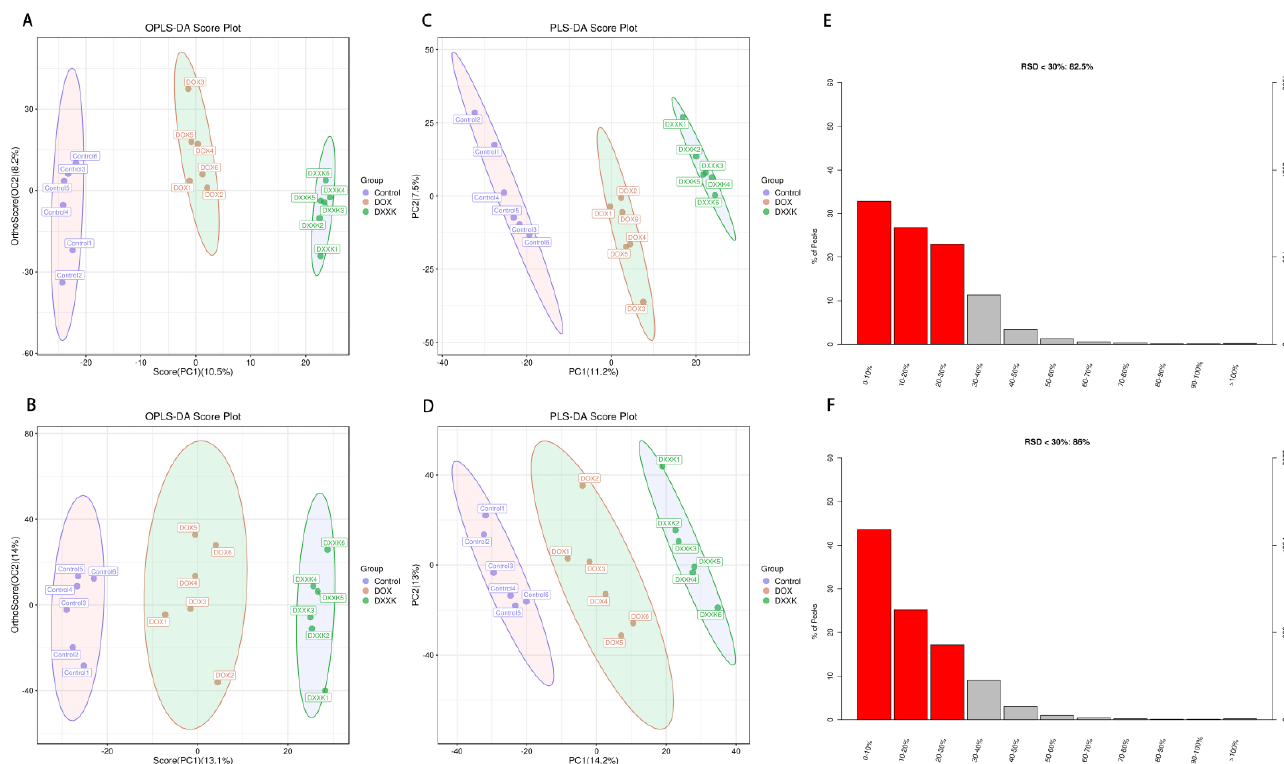
Figure 5. Metabolic profiles and differentiation of the control, DOX and DXXK groups by multivariate analysis. OPLS − DA score scatter plots in the ESI+ mode ( A ) and ESI − mode ( B ); S − plot of the PLS − DA model in the ESI+ mode ( C ) and ESI − mode ( D ); RSD in the ESI+ mode ( E ) and ESI- mode ( F ).